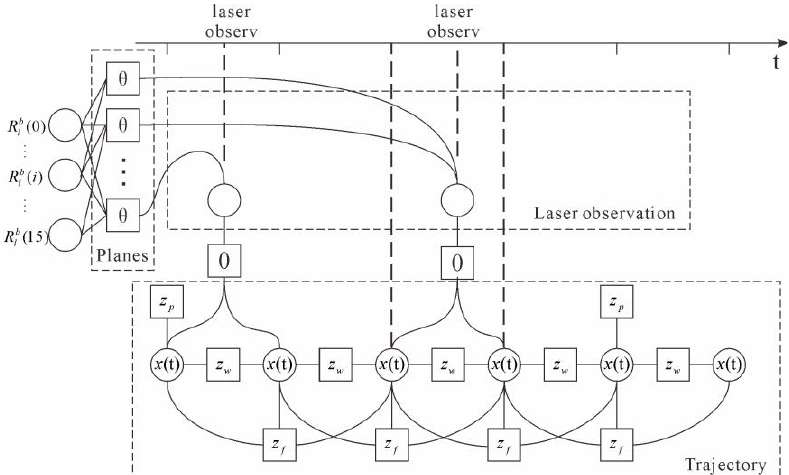
Fig.3 Dynamic Networks of the unknowns and observations involved in the proposed